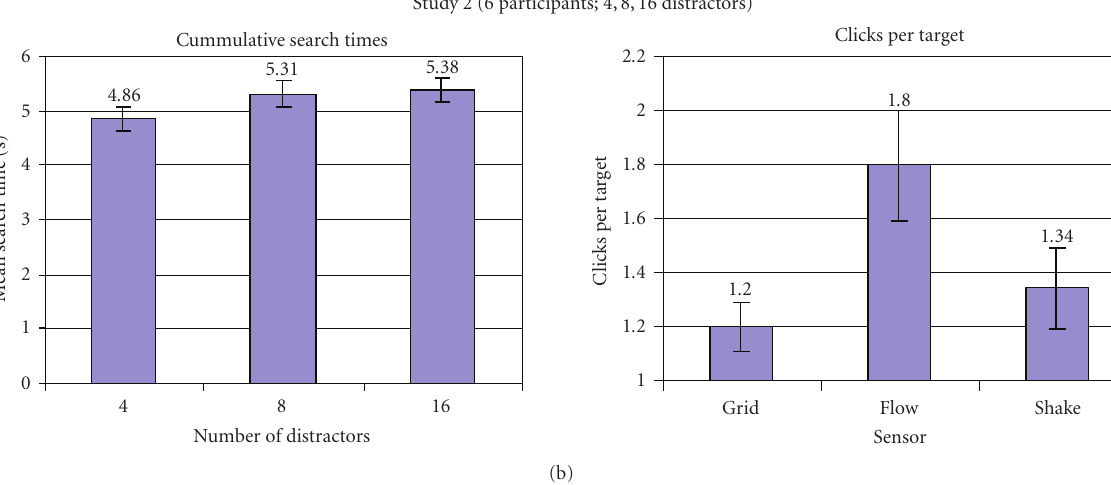
implementation used three zoom regions for three